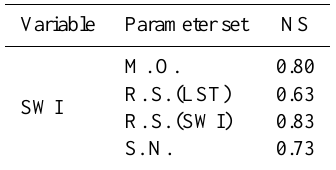
Table 12. The Casentino basin. Values of NS on SWI series ob- tained with the different parameter sets. The mean basin scale has been